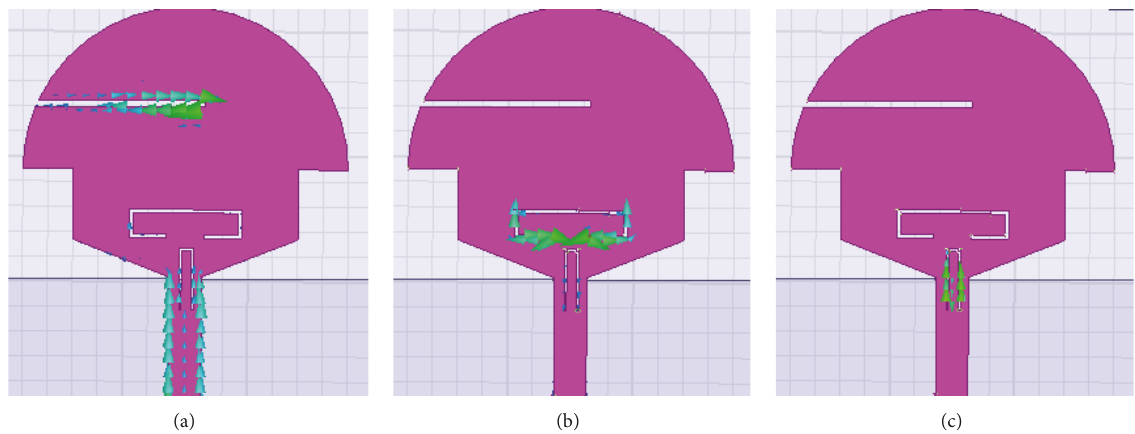
Figure 9: Vector current distribution of the UWB antenna (a) 3.5 GHz, (b) 5.4, and (c) 8.2 GHz.